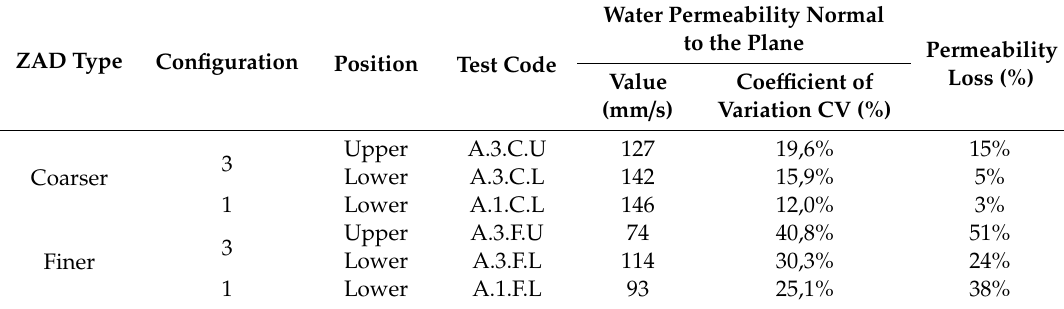
Table 5. Geotextile B results.